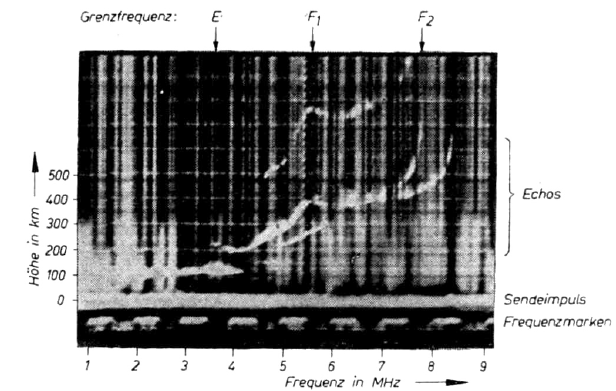
Figure 17. Ionogram at noon, Juliusruh, June 1956.